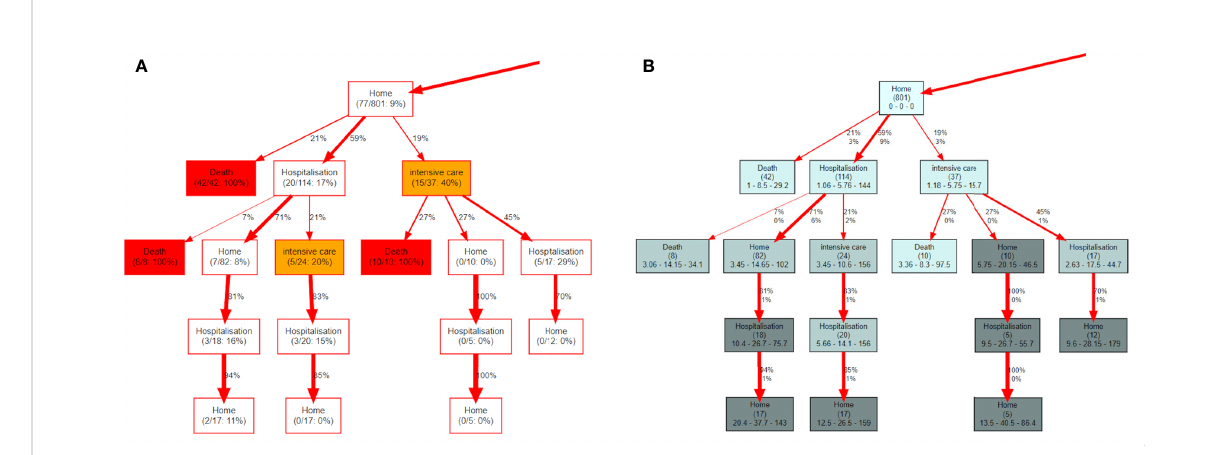
left branch after the COVID-19 test event in the whole graph of Figure 5. The full tree is available in Supplementary Figure S2. Another interesting variable to observe is the time spent to reach each node. In Figure 6B each node displays the number of hits in parentheses and a triplet of numbers indicating the minimum, the median and the maximum time, respectively, needed to reach the node. The full tree is available in Supplementary Figure